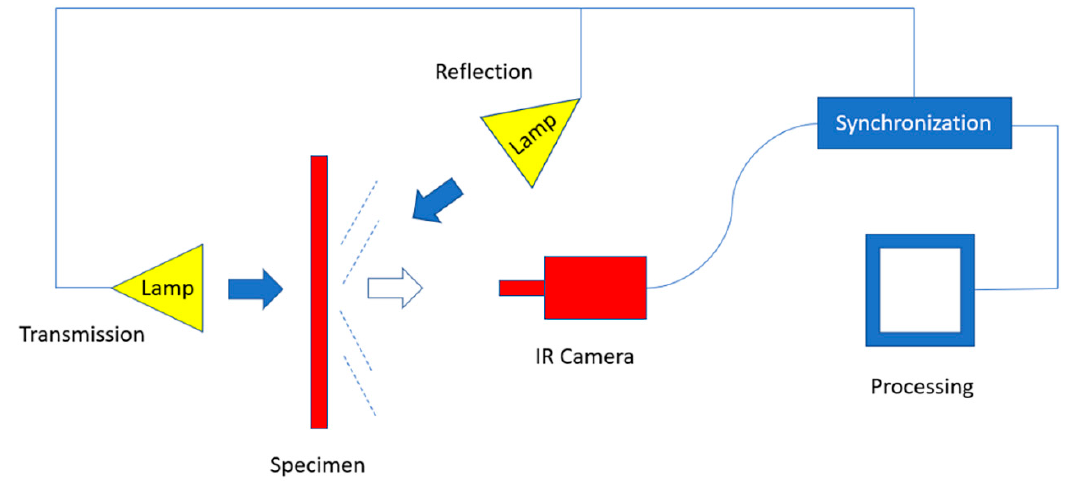
Figure 2. Experimental setup in pulsed thermography (PT).